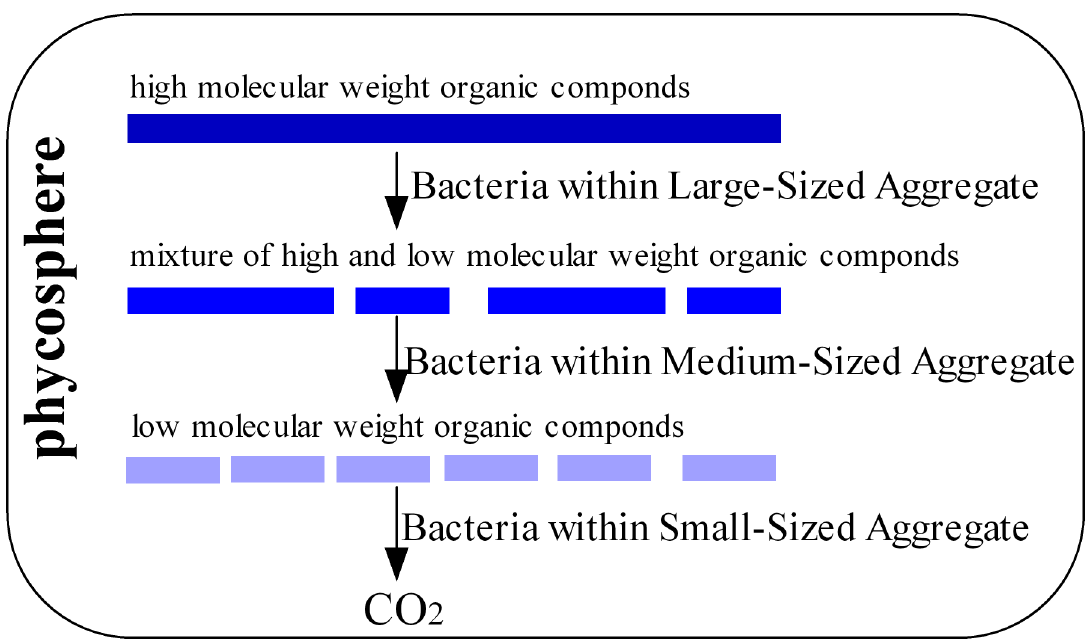
Figure 5. Organic carbon-utilization conceptual model illustrating the role of bacteria on different-sized aggregates in the cyanobacterial